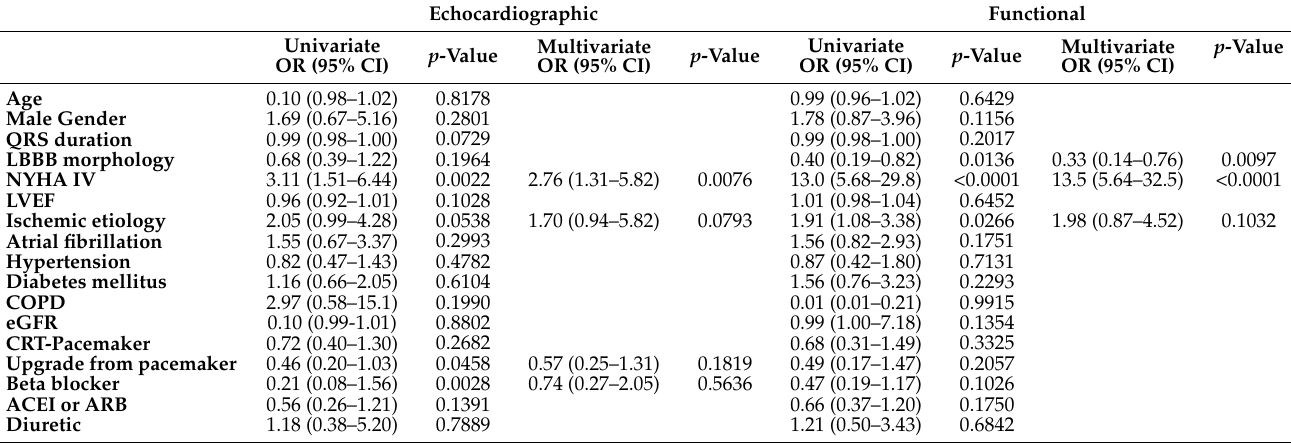
Table 4. Predictors of nonresponse by response